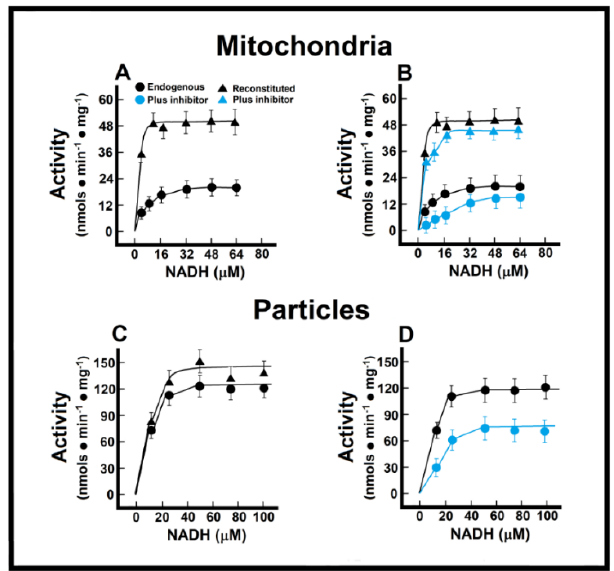
Figure 3. Mitochondrial NADH oxidation without (Panel ( A )) and with the inhibitor EFA (Panel ( B )); NADH oxidation by mitochondrial particles without (Panel ( C )) and with the inhibitor EFA (Panel ( D )). Kinetics of endogenous mitochondrial NADH oxidation and the reconstitution of the malate-aspartate shuttle. Results are expressed as mean ± S.E. of three control animals and five rats treated with ISO per experimental point of the kinetics of the endogenous or reconstituted malate-aspartate shuttle in the absence or the presence of the inhibitor, ethoxyformic anhydride (EFA). Symbols for the experimental groups at the top of panel ( A